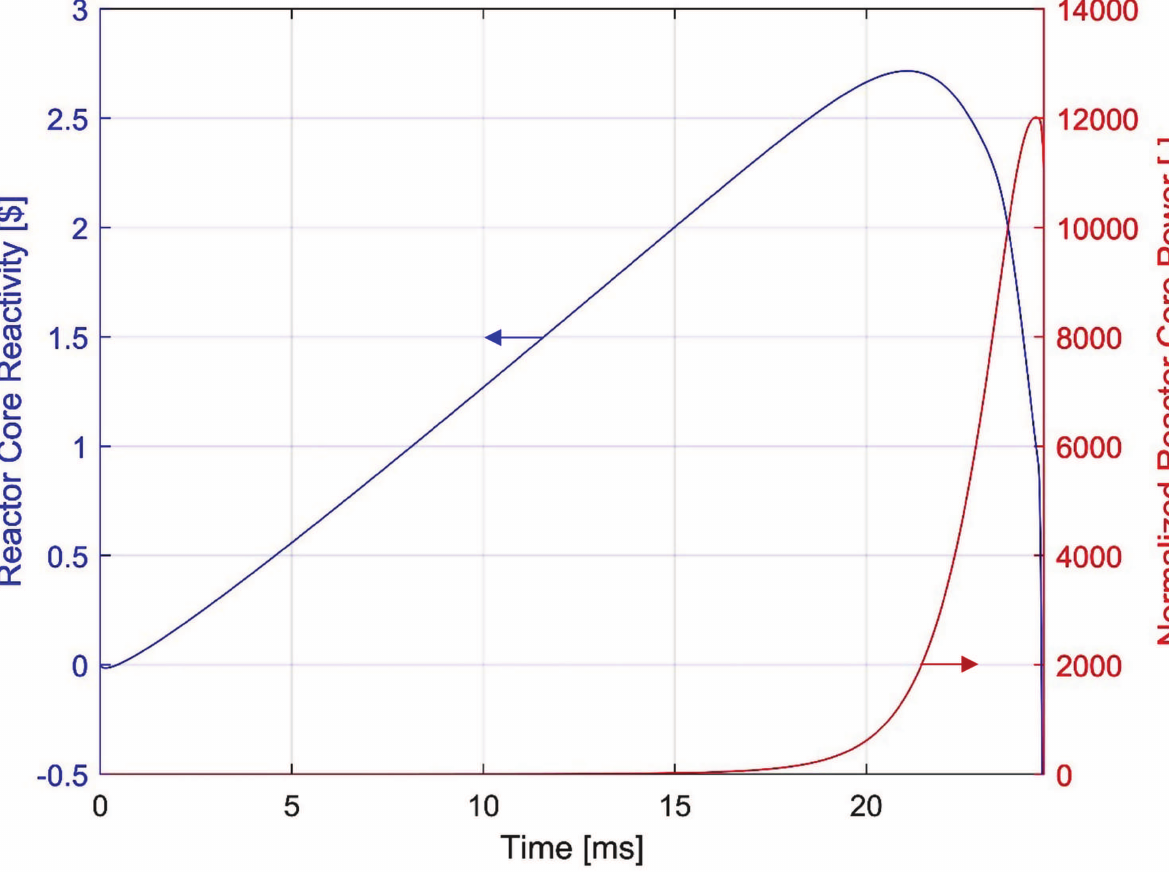
Fig. 3. Evolution of the reactor core reactivity and the corresponding reactor core power as calculated by employing the HCDA